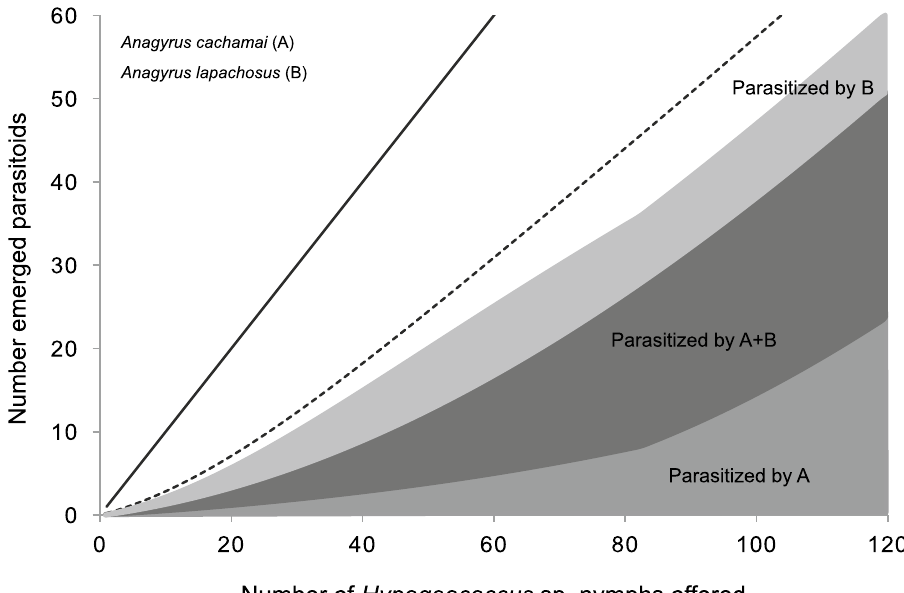
Figure 4. Expected functional response in the interaction between the parasitoids Anagyrus cachamai ( A ) and A. lapachosus ( B ), when the nymphs of Hypogeococcus sp. were first exposed to A. cachamai . Black line: number of nymphs offered is equal to the number of nymphs attacked by parasitoids. Dotted line: females of A. lapachosus do not have a host selection behavior; therefore, the number of nymphs attacked is at random.